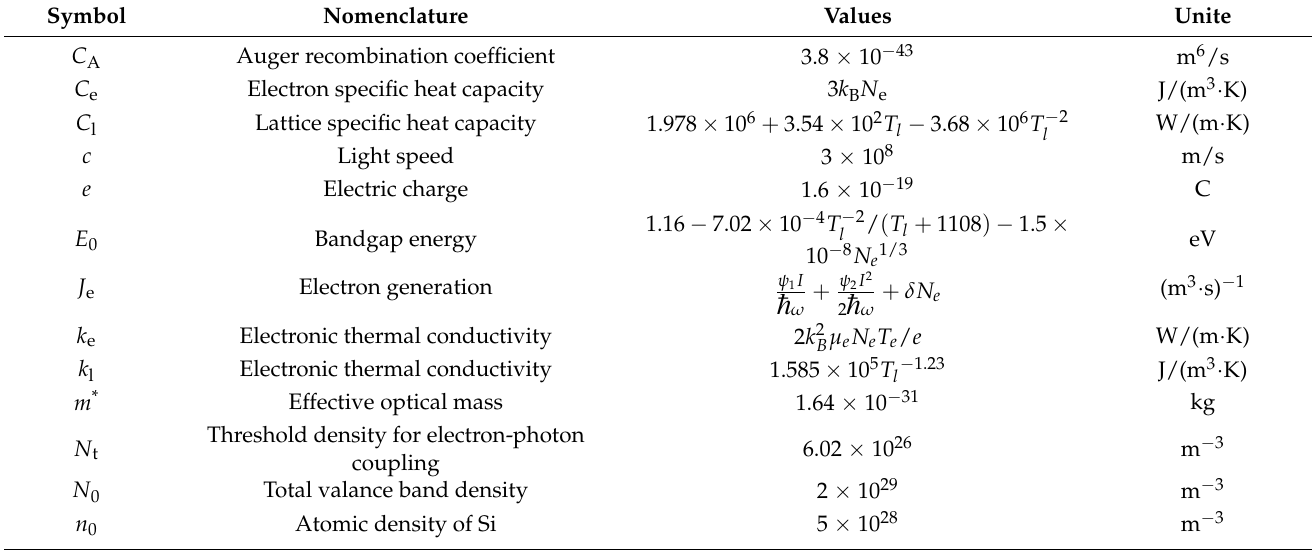
Table 1. The parameters used in the simulation